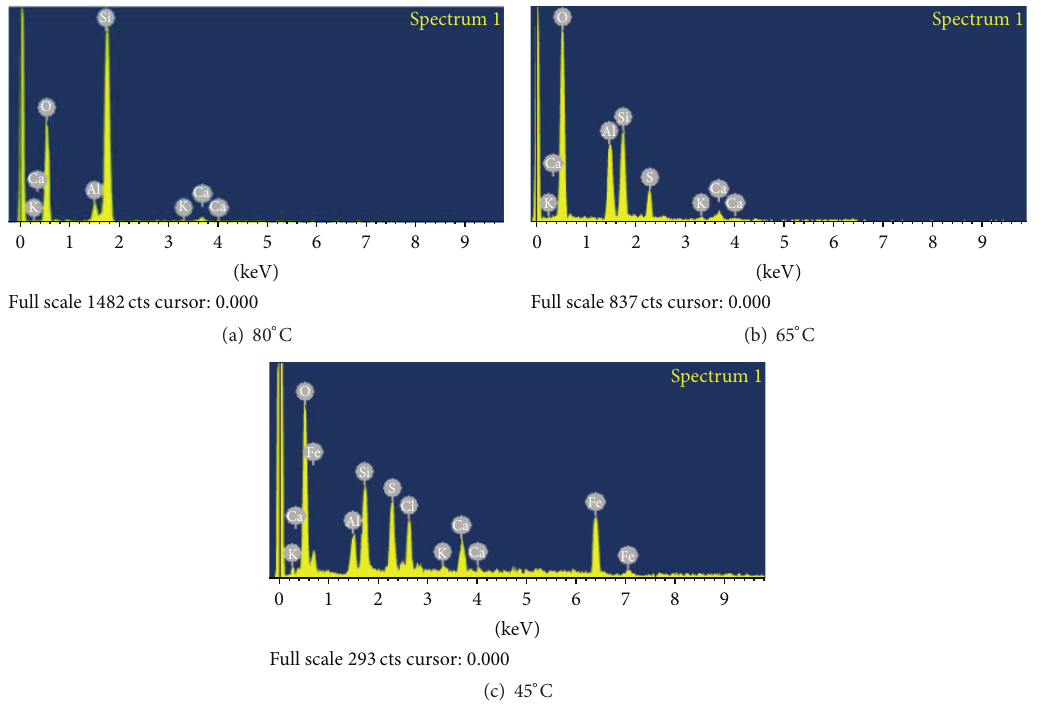
Figure 7: The energy spectrum diagrams of the ash particles under different wall